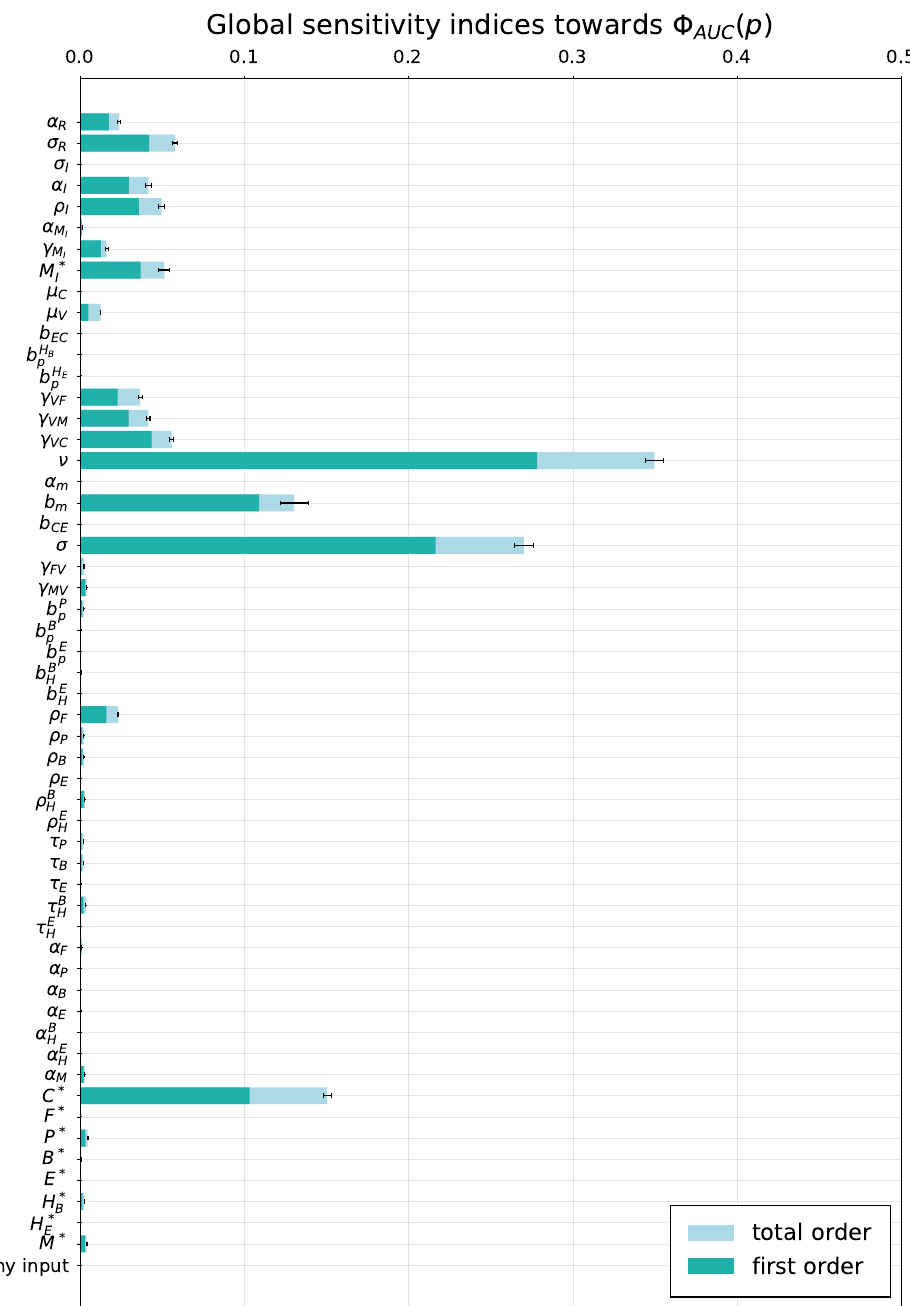
Figure 6. Global sensitivity. Total order- and first order sensitivity indices for cumulative vi- ral load Φ AUC ( p ) = 1.6 × 10 8 . The errorbars indicating the standard error of the mean over N r = 10 resamples are shown for the total-order